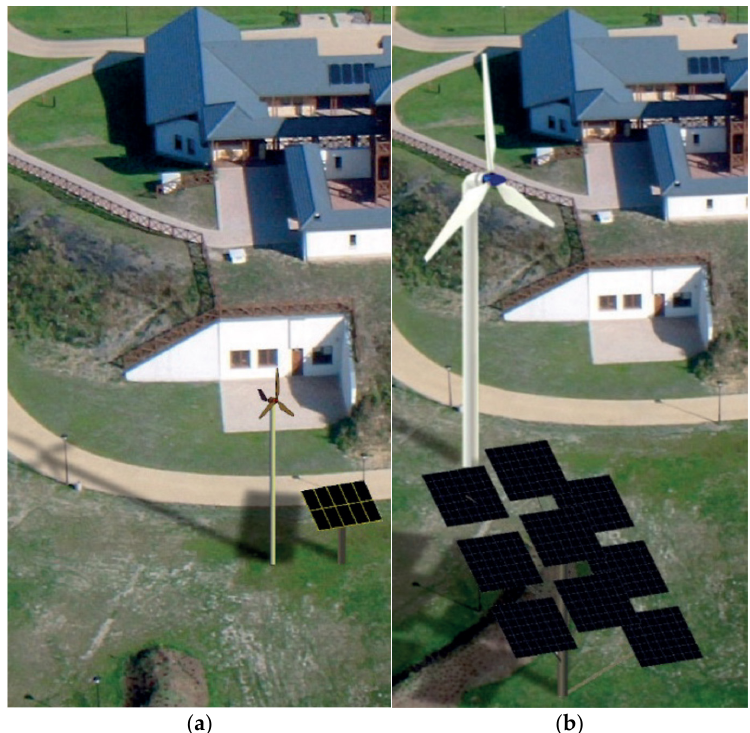
Figure 5. Visualization of the wind turbine and photovoltaic installation for the needs of the SBG: ( a ) a system that meets 5% of the energy demand; ( b ) a system that meets 100% of the energy demand [77]. Table 3. The utilization of the SWIND 3200 turbine and the Zefir D21-P70-T18 turbine under existing wind conditions in the RBG’s area (according to [75], based on [77]).